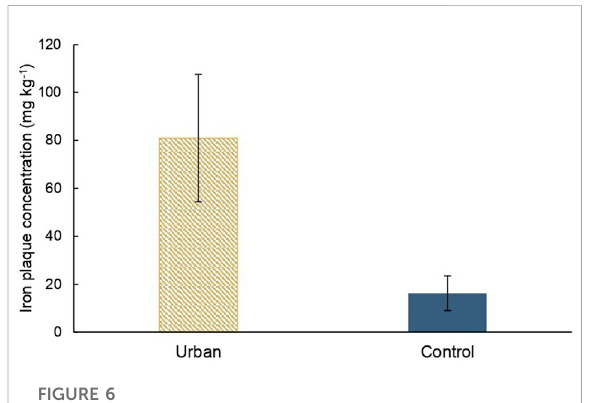
FIGURE 6 Mean iron plaque concentrations on A. marina pneumatophores ’ surfaces (mg kg − 1 ) at both sites with error